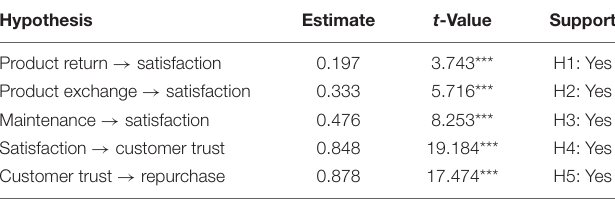
TABLE 6 | Hypotheses results.